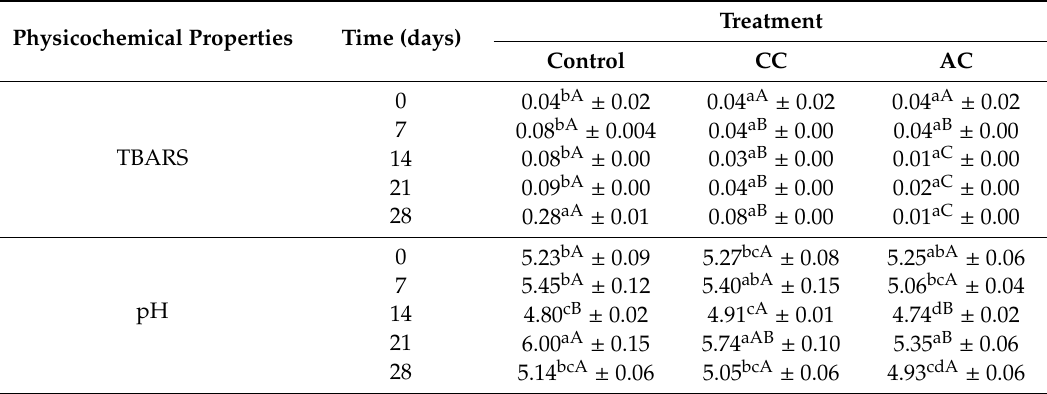
Table 4. E ff ect of active coating containing microencapsulated MOEO and BEO on TBARS (mg malonaldehyde / kg meat), and pH of fresh pork meat stored at 4 ◦